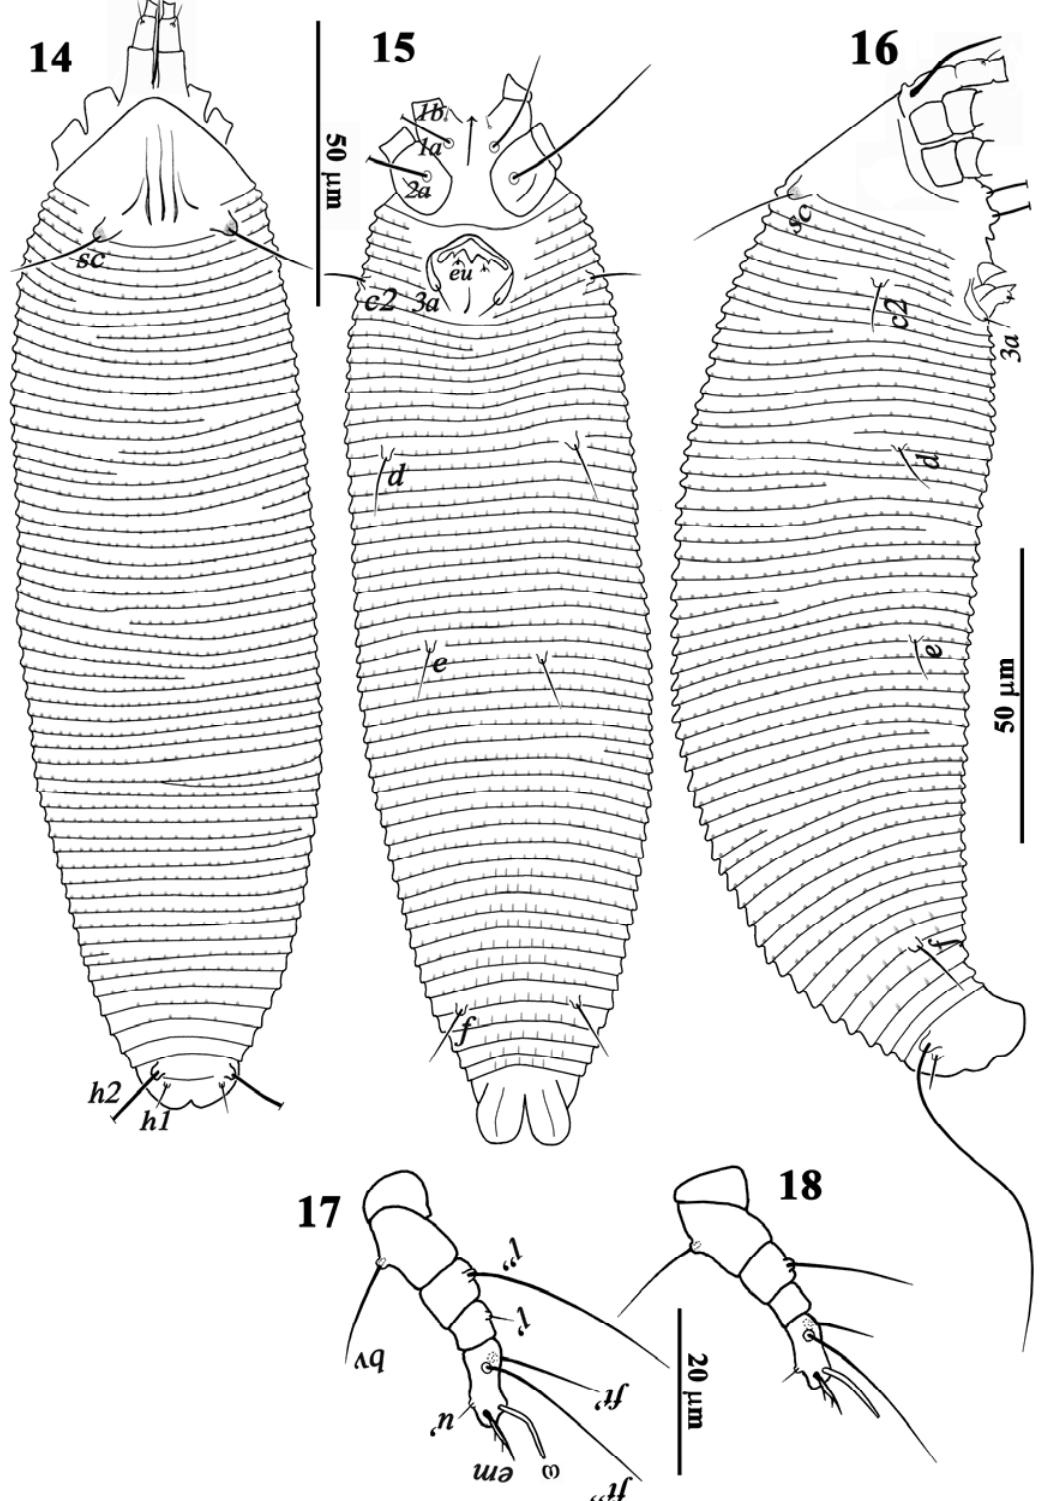
F IGURES 14-18. A. tristriatus (Nalepa) (Male): 14. Dorsal view of male; 15. Ventral view of male; 16. Lateral view of male; 17. Leg I; 18. Leg